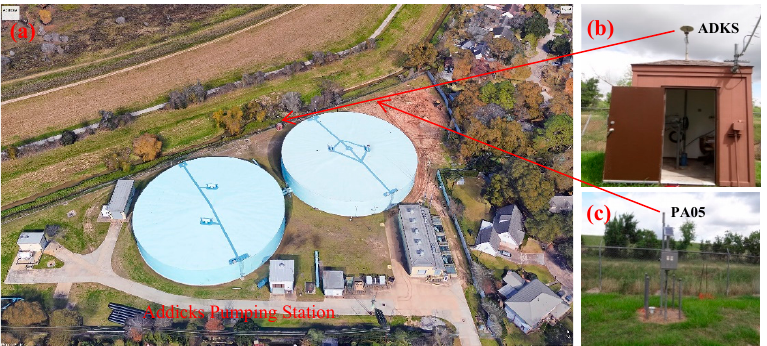
Figure 13. (a) Site view at the Addicks groundwater pumping station (Google Image); (b) the borehole extensometer and the permanent GPS antenna ADKS; (c) the permanent GPS antenna monument of the HGSD PAM station PA05. The distance between these two GPS antennas (ADKS, PA05) is approximately 50 m.